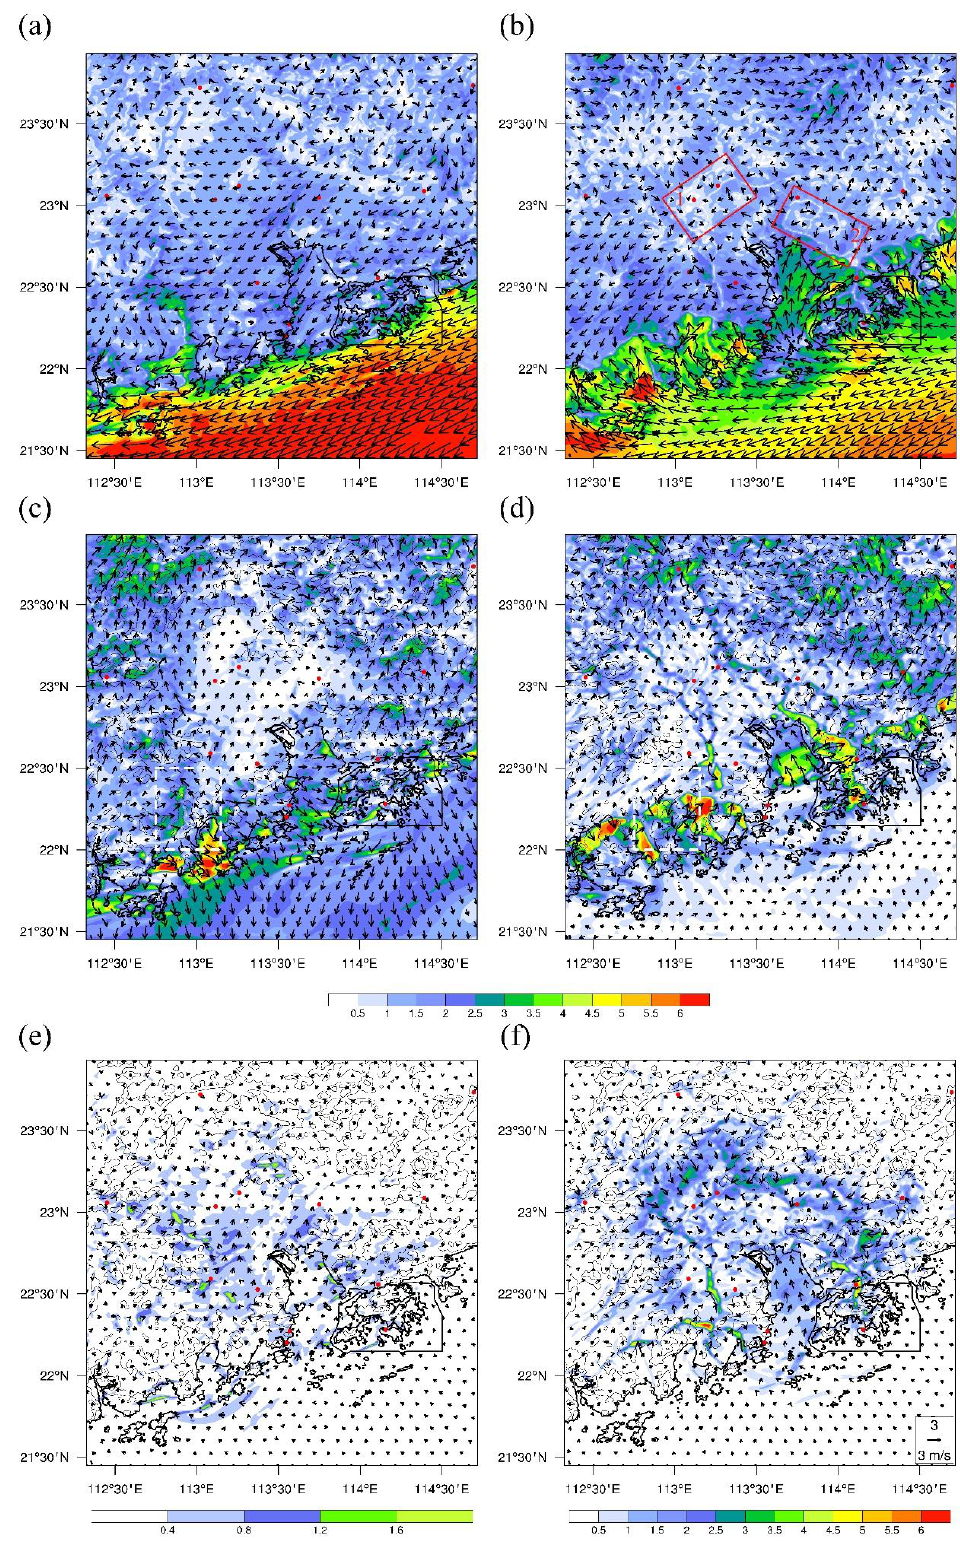
Figure 4. The 10 m wind vectors and wind speed (the color shade; unit: m/s) of CTRL ( a , b ), CTRL minus NoTer ( c , d ), CTRL minus NoUrb ( e , f ). The red dots mark the city centers and the two red boxes in Figure 4b indicate the Foshan–Guangzhou (box 1) and Dongguan–Shenzhen (box 2) convergence zones. The white dashed box in Figure 4c,d shows the terrain of southeastern Jiangmen City, the left column is for 1000 LST and the right is 1600